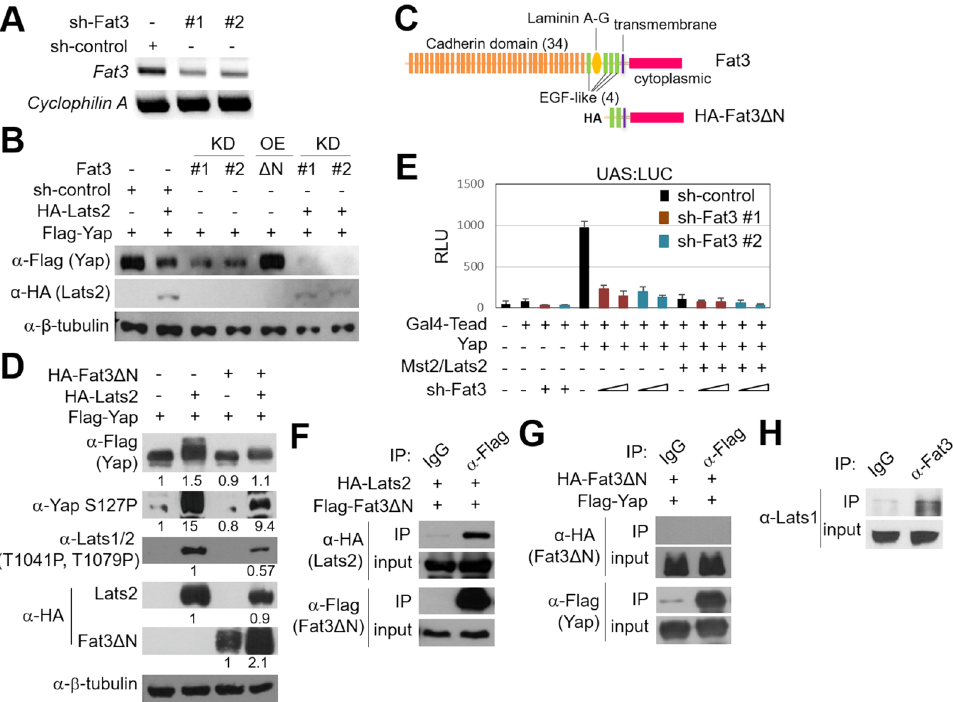
Figure 4. Fat3 knockdown destabilizes and attenuates Yap transcriptional activity. ( A ) P19 cells were transfected with sh-control and sh-Fat3 (target sites #1 and #2), followed by RT-PCR to test knockdown efficiency. ( B ) P19 cells were transiently transfected with sh-Fat3 and Fat3ΔN together with Flag-Yap, HA-Lats2 and HA-Mst2. After 48 h, cell lysates were analyzed by western blotting. ( C ) Schematic representation of the mouse Fat3 full length and N-terminus deleted construct of Fat3 (ΔN). ( D ) The phosphorylation level of Yap by Lats2/Mst2 was attenuated by overexpression of Fat3ΔN. anti-S127P Yap antibody detects the phosphorylated Serine 127 residue of Yap. anti-T1041P, T1079P Lats1/2 antibody detects the phosphorylated Lats2 on Thr1041 and Thr1079. Quantification of each signal measured by ImageJ and then normalized by tubulin is shown below each band. ( E ) Luciferase reporter assay with UAS:LUC and Gal4-Tead showed the transcriptional activity augmented by Yap, that was abrogated by Fat3 knockdown. Values are means ± sd. At least 3 replicate experiments were repeated in P19 cells. ( F,G ) Fat3 interacts with Lats2 but not with Yap. Co-immunoprecipitation assay with HEK293T cells transiently transfected with the expression vectors for HA-tagged Lats2 and Flag-tagged Fat3ΔN ( F ), and HA-tagged Fat3ΔN and Flag-tagged Yap ( G ), respectively. ( H ) CoIP assay with E11.5 mouse spinal cord extract showed interaction between Fat3 and Lats1. To detect same samples with different antibodies, membranes were cut prior to hybridization or reprobed. Uncropped original western blot images are included in the “Supplementary Data”, with cropped areas highlighted with colored